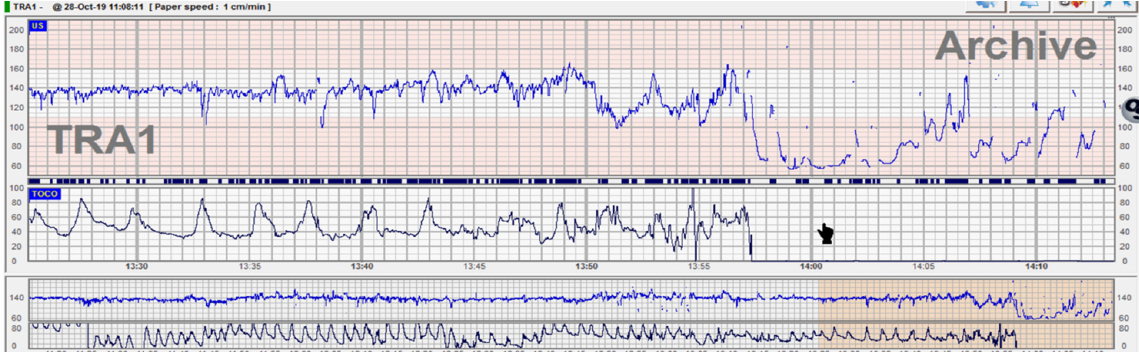
Figure 1. Umbilical cord prolapse associated with acute bradycardia. We present a case of a para 3 patient who was admitted in active labor at 8 cm dilation with intact membranes. On vaginal exam- ination, the cervix was fully effaced with bulging membranes, and therefore she was directed to a labor room. CTG trace was normal, and therefore she was proposed for controlled ARM (artificial